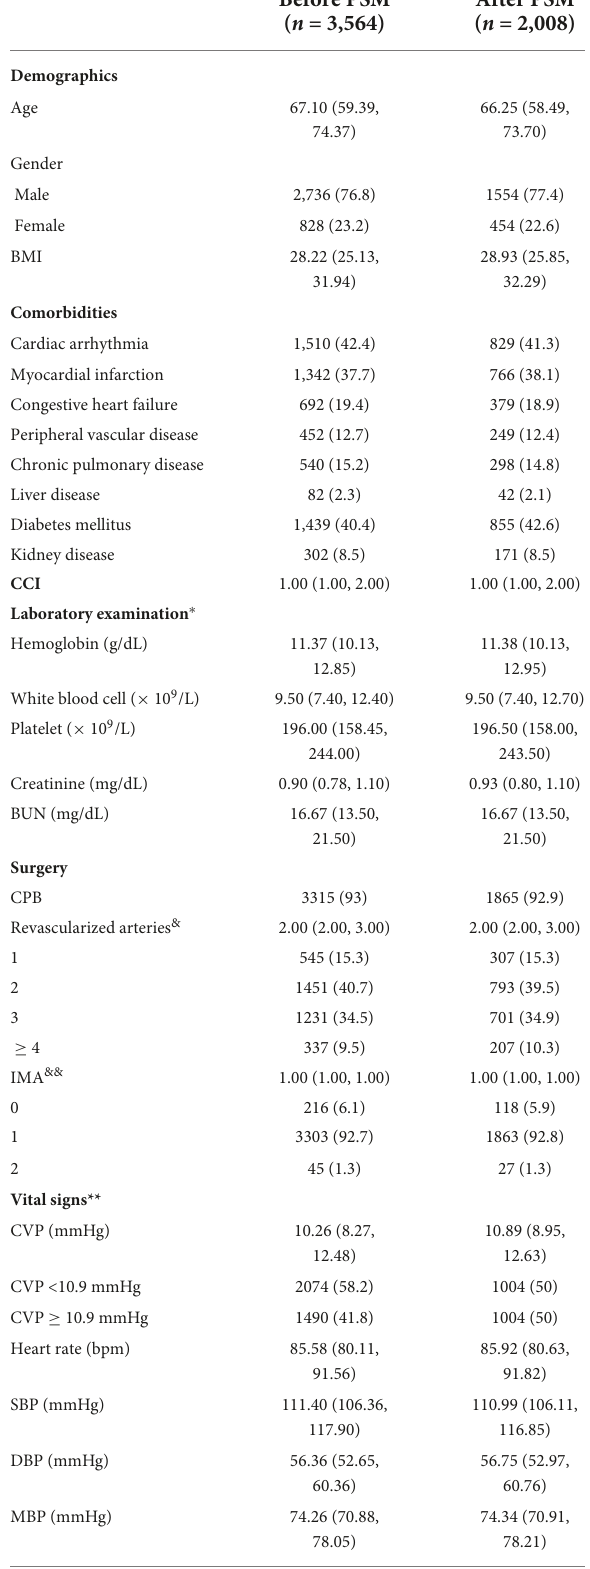
TABLE 1 Clinical characteristics of patients undergoing